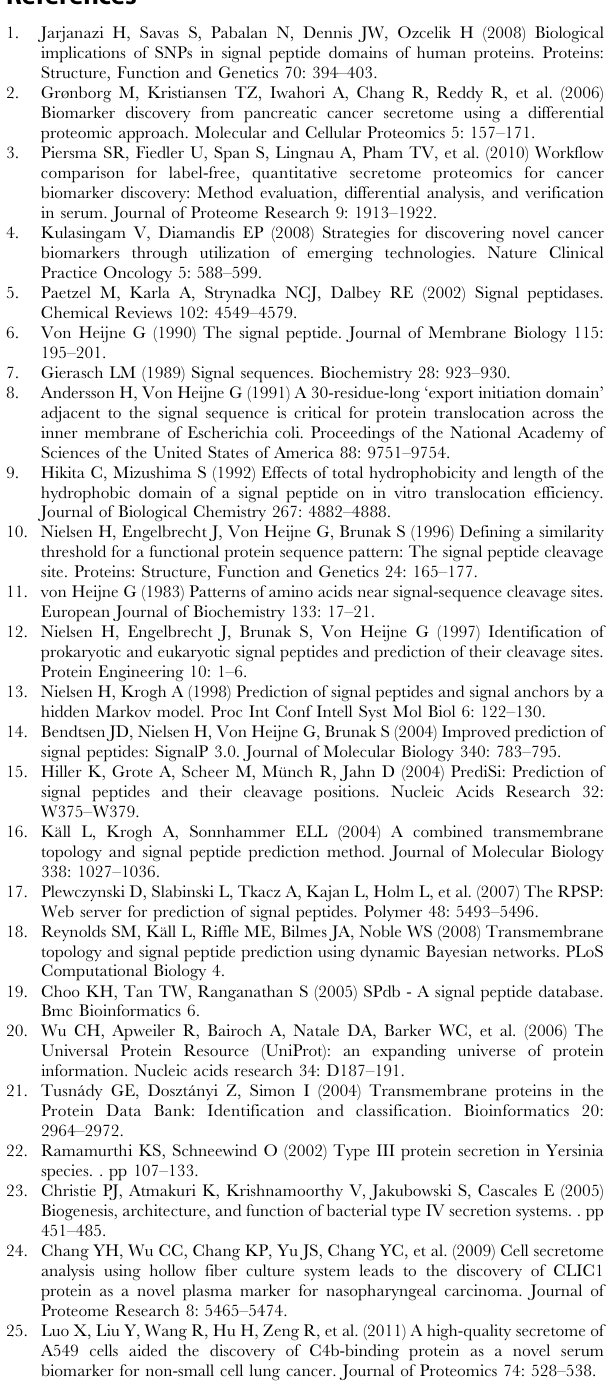
Table S1 General analysis of proteomes in the HAMAP